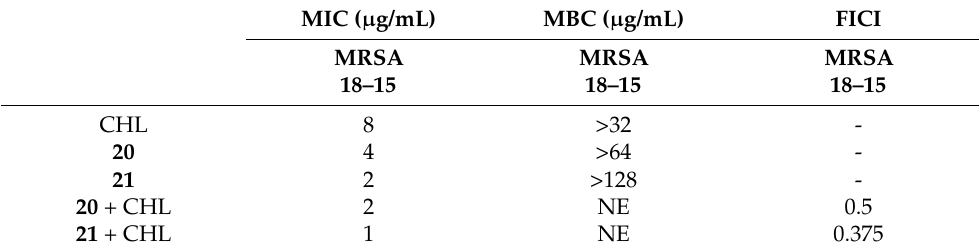
Table 2. Synergistic effect of CHL with compounds 20 and 21 against MRSA 18-15.